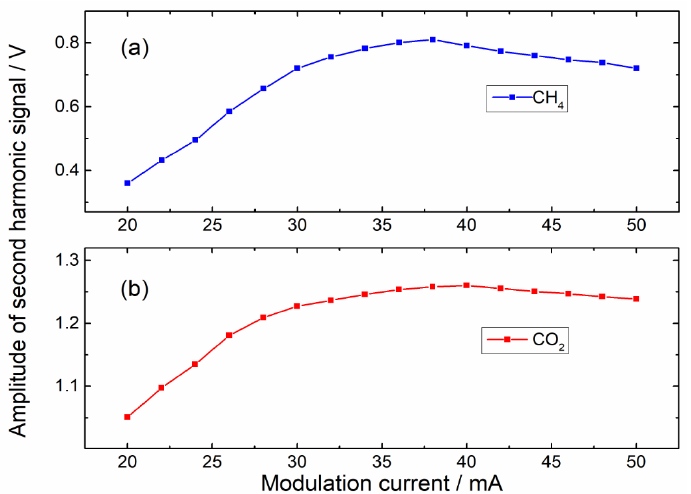
Figure 3. Amplitudes of second harmonics of CH 4 and CO 2 , corresponding to different modulation currents. ( a ) CH 4 ; ( b ) CO 2.